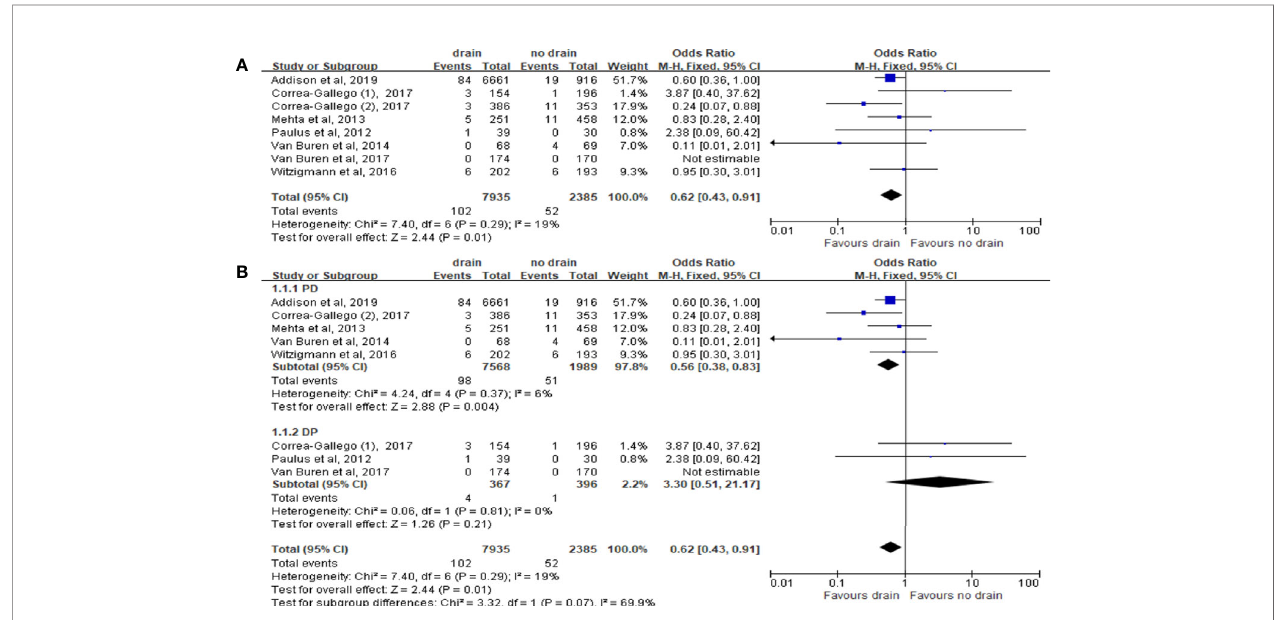
FIGURE 2 | The assessment of the quality of RCTs.